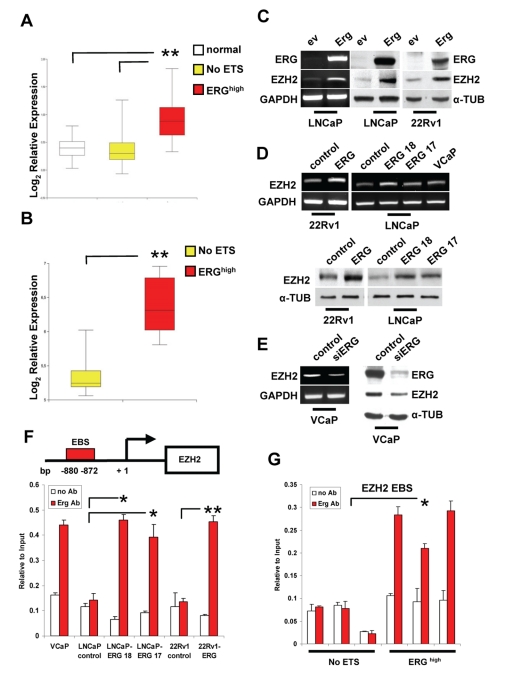
ERG induces EZH2 expression.
A. EZH2 expression in tissue samples. Microarray data are presented as log2 ratios compared to the reference. B. EZH2 expression in NoETS and ERGhigh tumors in the Wallace et al. microarray dataset. C. EZH2 expression in LNCaP and 22Rv1 cells transiently transfected with empty (ev) or ERG expression (Erg) vector determined by RT-PCR (left) and Western blot (right). D. EZH2 level in control and stable ERG-expressing 22Rv1 and LNCaP cells determined by RT-PCR (upper) and Western blot (bottom). E. EZH2 level in VCaP cells transiently transfected with control and ERG-specific (siERG) siRNA determined by RT-PCR (left) and Western blot (right). F. ChIP in the indicated cell lines with ERG antibody and qPCR with primer sets encompassing the EBS in the EZH2 promoter. Positive (MMP3 promoter) and negative (ETS2) controls are shown in Fig. S6A-B and 7A, respectively. G Tissue specimens of ERGhigh and NoETS tumors were subjected to ChIP with anti-ERG antibody and analyzed by qPCR. ETS2 was used as negative control (Fig. S7B). *, P<0.01; **, P<0.0001.